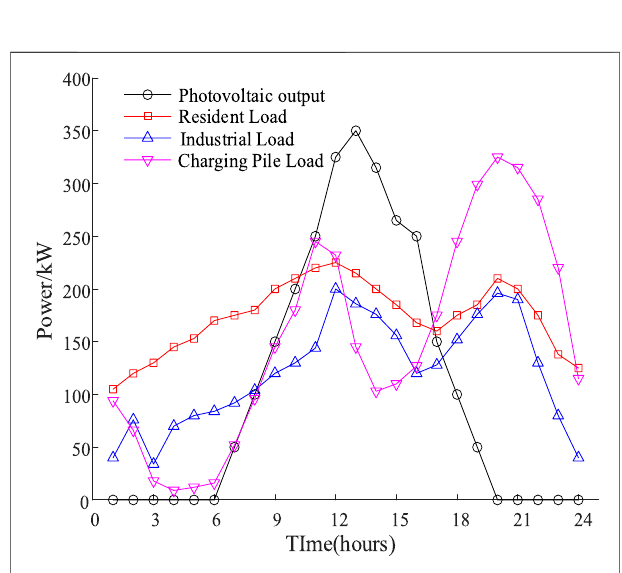
FIGURE 3 | Typical intra-day predicted values of photovoltaic output and